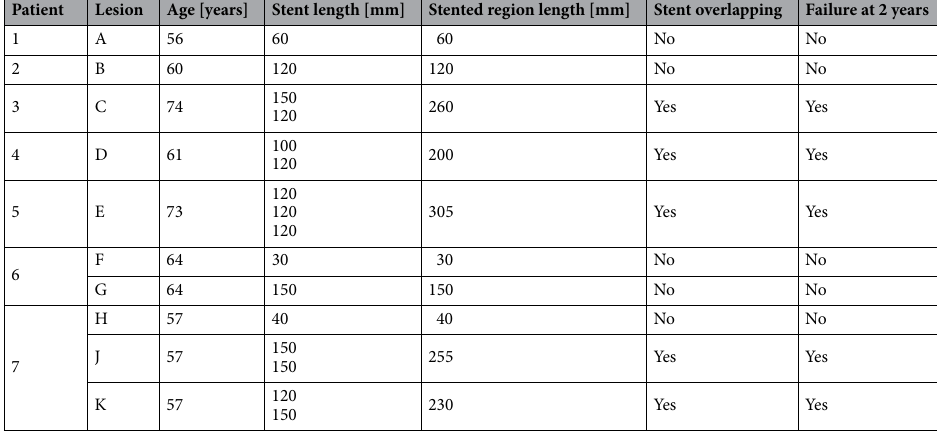
Table 1. List of demographic and clinical